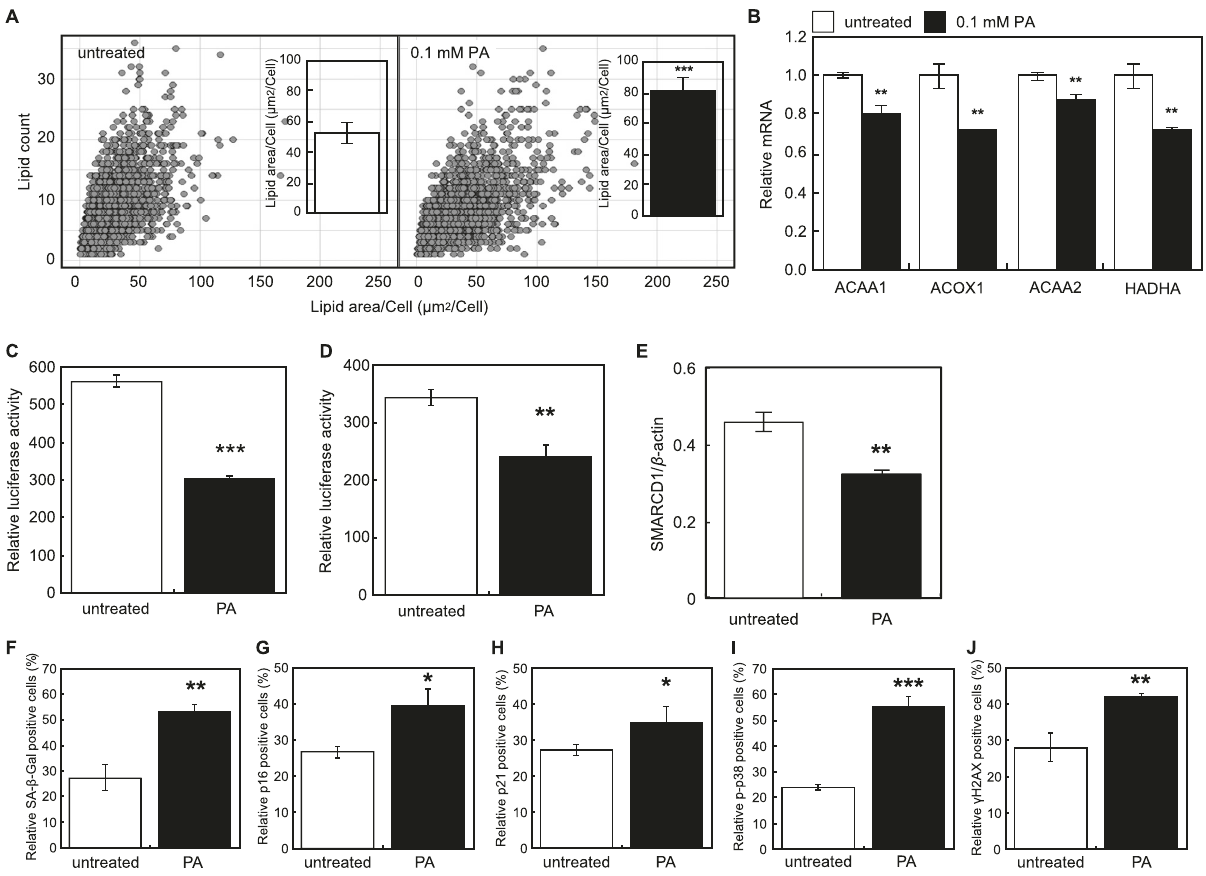
Fig. 2 Palmitic acid induces cellular senescence and accumulation of lipid in hepatocytes. ( a ) HepG2 cells were cultured in the absence or presence of 0.1 mM palmitic acid, and the number of lipid droplets and the lipid area were quanti fi ed. Average lipid area was shown as a bar chart. ( b ) Relative expression of ACAA1, ACOX1, ACAA2, and HADHA in HepG2 cells cultured in the absence or presence of 0.1 mM palmitic acid. PPAR-dependent transcription ( c ) and transcriptional activation ability of PGC-1 α ( d ) were assessed. ( e ) SMARCD1 relative gene expression in HepG2 cells in the absence or presence of 0.1 mM palmitic acid (PA). Activity and expression of senescence markers (F, SA- β -Gal; G, p16; H, p21; I, phosphor p38; J, γ H2AX) were measured in HepG2 cells cultured in the absence or presence of 0.1 mM PA. Data were analyzed by two- sided Student ’ s t -test and are expressed as mean ± SD. P < 0.05 was considered signi fi cant ( * P < 0.05; ** P < 0.01; *** P <